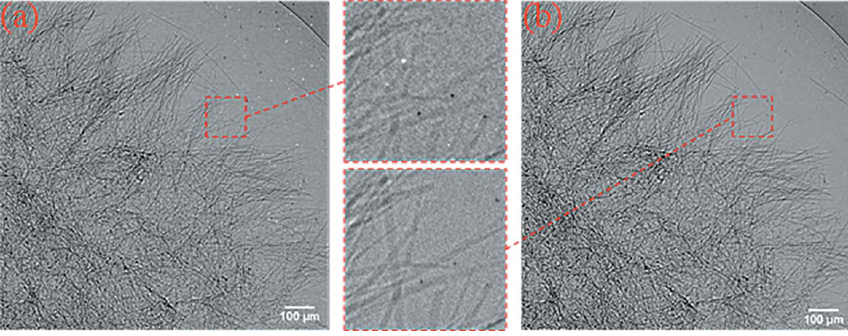
Figure 10 Results of the 2 (cid:2) 2 mode SRX experiment with the animal sponge. ( a ) The projection (pixel size: 1.43 m m (cid:2) 1.43 m m; pixel number: 840 (cid:2) 840). ( b ) The oversampled image with deconvolution (pixel size: 0.715 m m (cid:2) 0.715 m m; pixel number: 1680 (cid:2) 1680). Panels ( a ) and ( b ) are only part of the image to show the details more clearly.